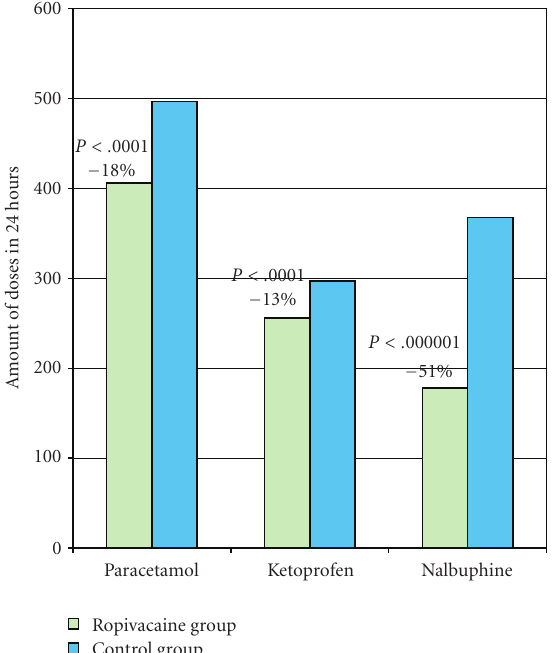
Figure 2: Percentage of patients needing analgesic administration over 24 hours.